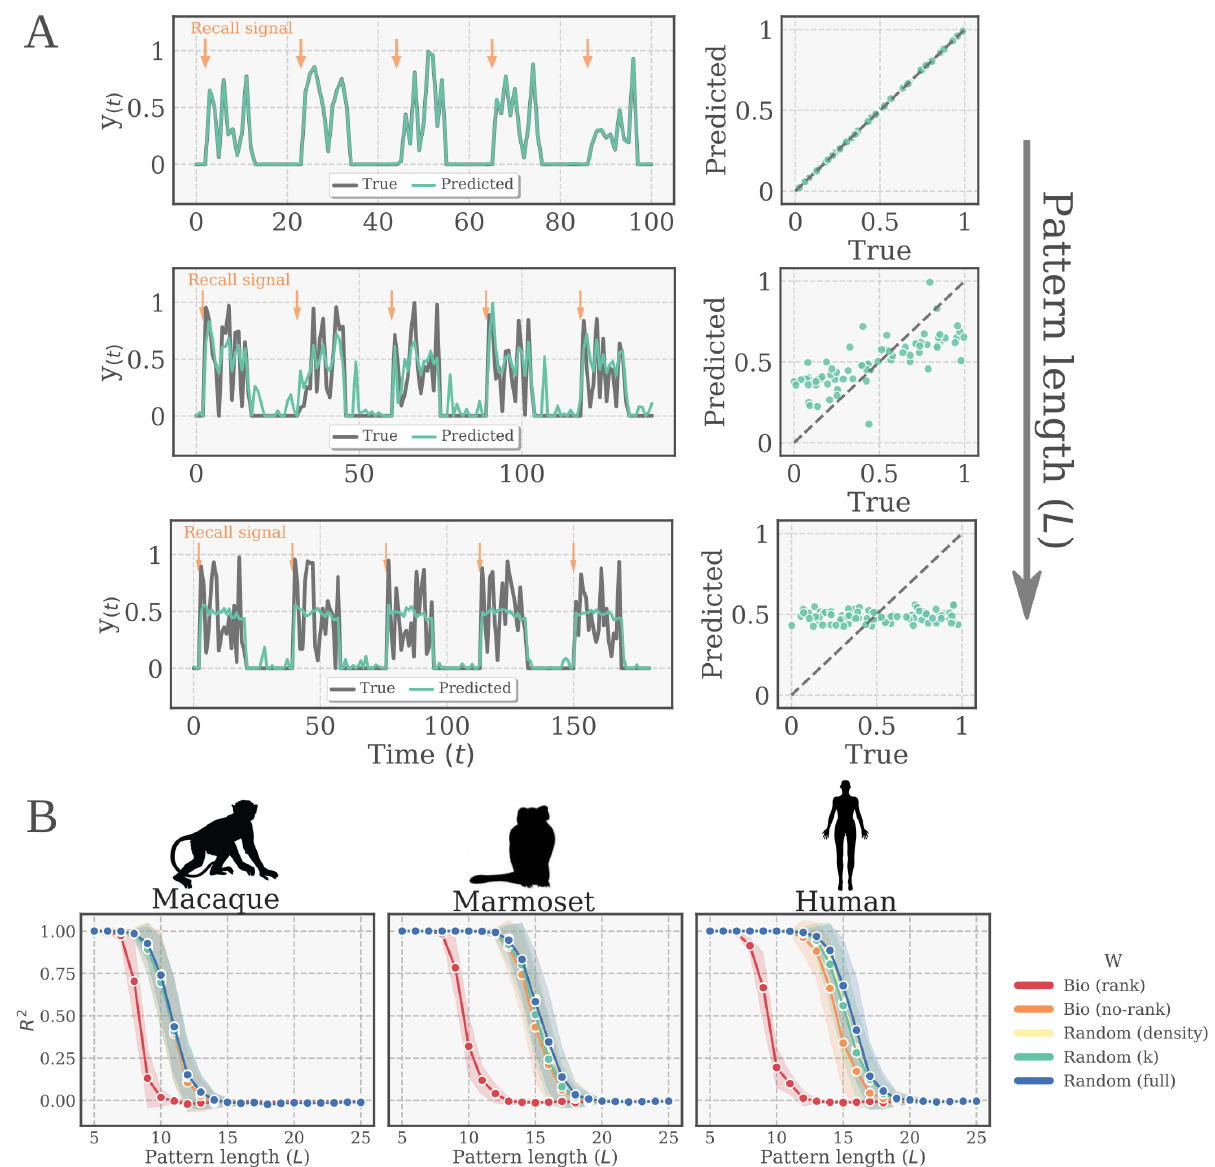
Fig 4. Sequence memory task. (A) (Upper) Schematic representation of one trial of the task. The input signal ( X 1 ) and the recall signal ( X 2 ) are feed as a time series into the network through two input neurons. When the recall signal is given ( X 2 = 1), the output neuron is supposed to deliver the memorized input of the last L steps. (Lower) Alternative representation of the task in terms of the input/output structure of the data. (B) Examples of actual and predicted times series for 5 trials at three different difficulty levels (pattern length, from top to bottom: L = 10/14/18). The scatter plots on the right show the predicted vs. the true output (as explained in main text). The BioESN in the example was built from human connectome with the Bio (no-rank) variation. (C) Performance of the bio-instantiated echo state networks (BioESNs) for different task difficulties (pattern length) for the three different species. The bio-instantiated reservoirs, Bio (rank/no-rank) , are compared to surrogates with random connectivity patterns. For each pattern length, 100 different networks with newly instantiated weights were trained (800 trials) and tested (200 trials). The curves depict the mean test performance and standard deviation across networks. neurons by an arbitrary scaling factor while preserving the wiring diagram of the original con- nectome (see Mapping and upscaling connectomes with bio2art for more details). Although not totally conclusive because of the different experimental methodologies, that approach brings us closer to a comparison across species connectomes (see Discussion). At the same